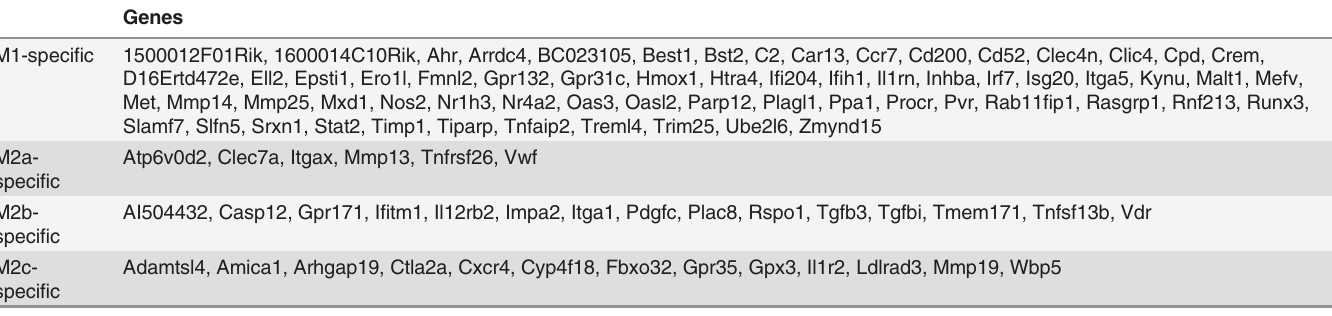
Table 5. M1 and M2a,b,c-speci fi c genes that are > 2-fold upregulated in our GAMs data set. Genes